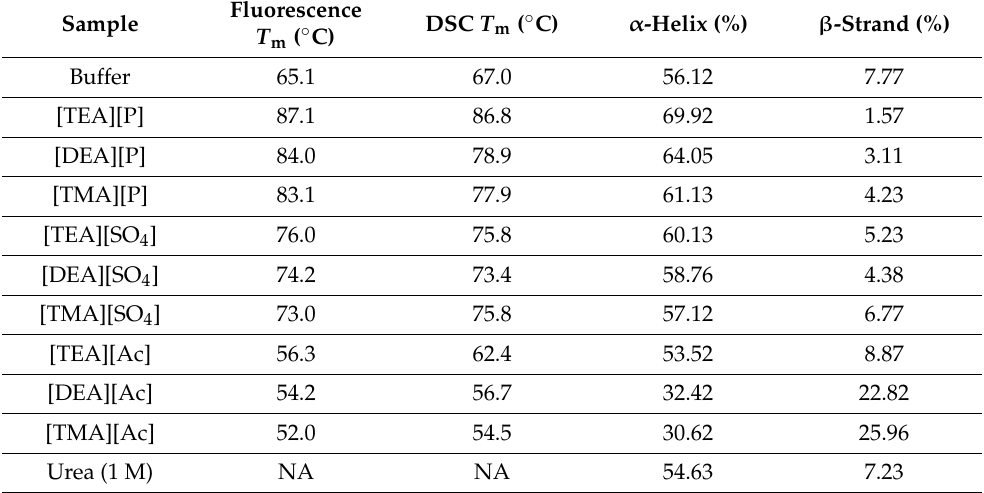
Table 3. Effect of various ILs on the melting temperature from fluorescence and differential scanning calorimetry (DSC) along with secondary structure composition of myoglobin determined from Far-UV CD spectra (adapted from reference